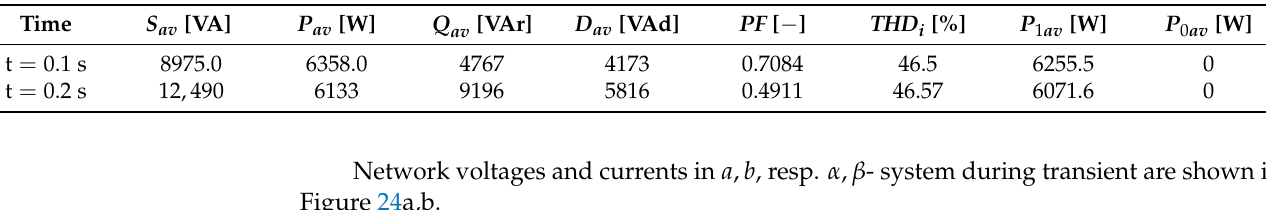
Table 36. Simulation results before and after the change (at steady states).